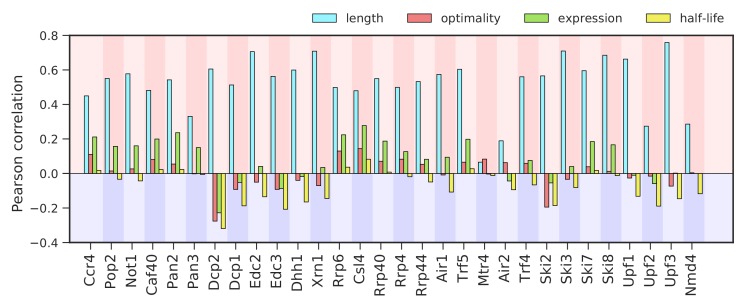
Correlation between binding to degradation factors and transcript length, codon-optimality, expression, and half-life.Pearson correlation values between the binding strength of degradation factors (total occupancy over each transcript) and transcript length, transcript optimality (Pechmann and Frydman, 2013), expression level (Baejen et al., 2017), and half-life derived by multivariate linear regression analysis (Materials and methods).